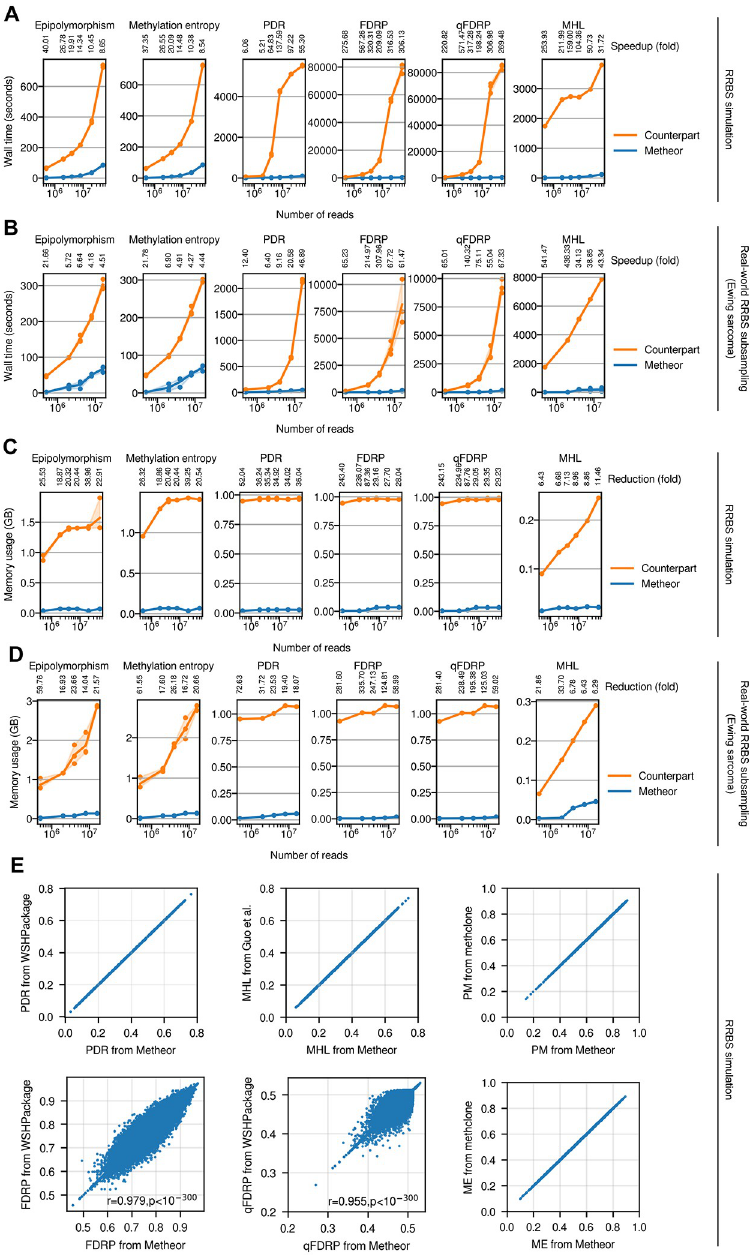
Fig 2. Performance benchmark and validity of the results. Benchmarking the running time of Metheor using (A) simulated RRBS dataset and (B) Ewing sarcoma RRBS dataset. Values below the name of each of the measures denote the amount of speedup (in fold) in Metheor compared to its benchmark counterpart. Benchmarking the memory usage of Metheor using (C) simulated RRBS dataset and (D) Ewing sarcoma RRBS dataset. Values below the name of each of the measures denote the amount of memory usage reduction (in fold) in Metheor compared to its benchmark counterpart. All the benchmark experiments were repeated for three times, except for MHL. Lines denote the average wall time and shades represent the 95% confidence interval. The wall time for MHL computation was measured for only once. (E) Validity of the results. CpG-wise (PDR, MHL, FDRP and qFDRP) and CpG quartet-wise (PM and ME) methylation heterogeneity levels were compared between Metheor and the corresponding reference implementations. Pearson’s correlation coefficient and corresponding p-values are shown for FDRP and qFDRP.